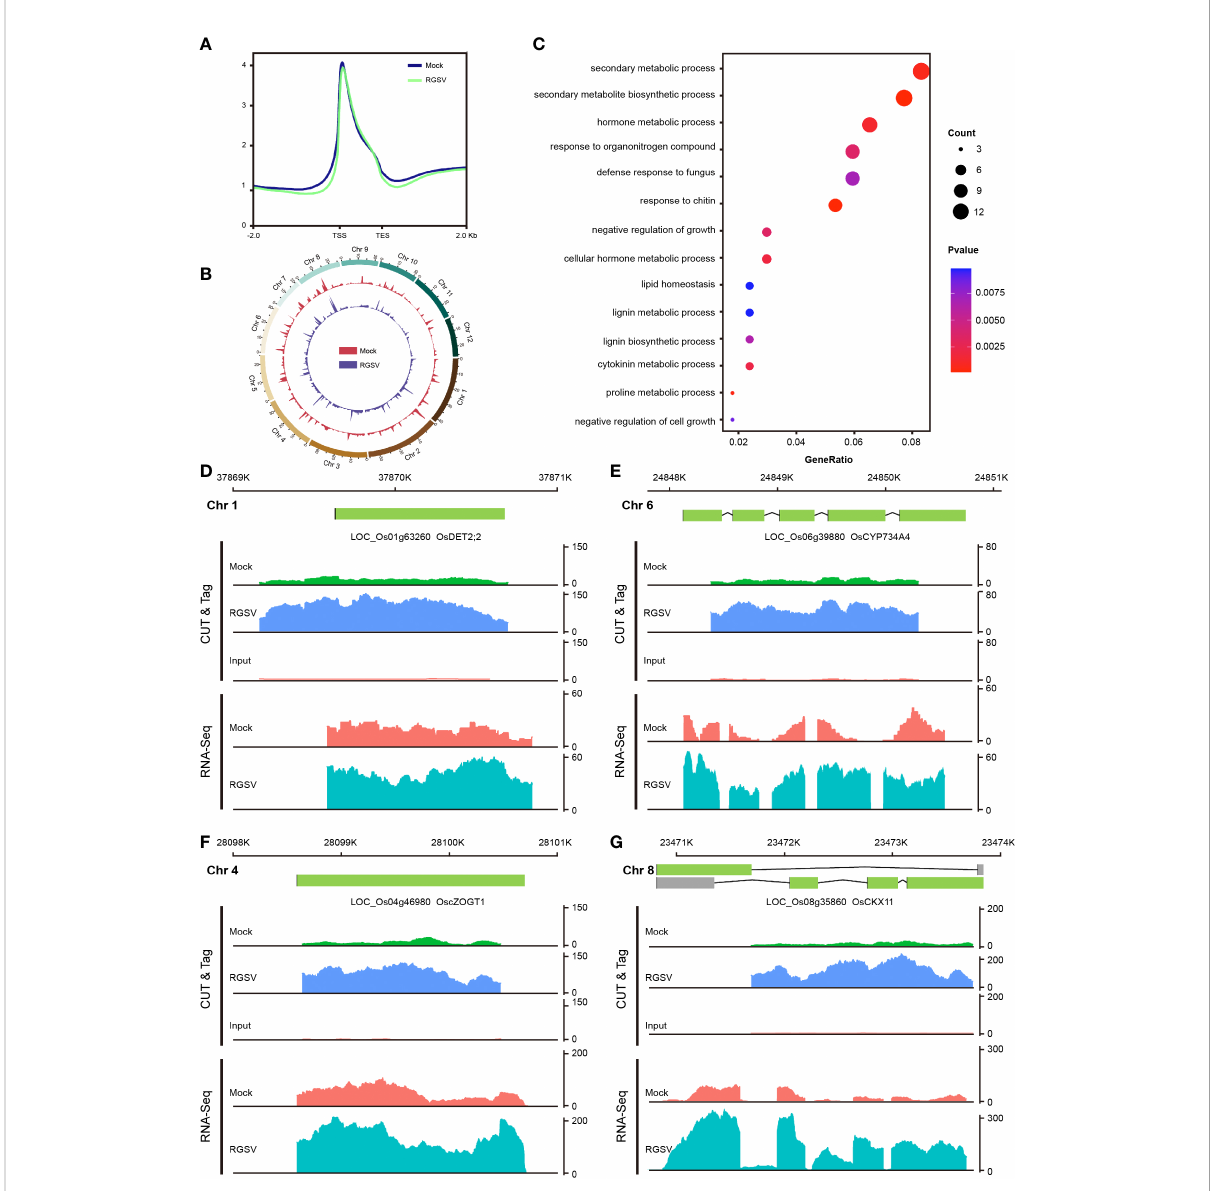
FIGURE 4 Genome-wide mapping of H3K9me3 and expression of its related genes after RGSV infection in rice. (A) Signal intensity of H3K9me3 in the TTS and TES intervals and its upstream and downstream 2kb. (B) Distribution of H3K9me3 in the whole rice genome. (C) GO enrichment analysis results of differential genes. (D – G) Gene browser view of multiple genes in CUT&Tag and